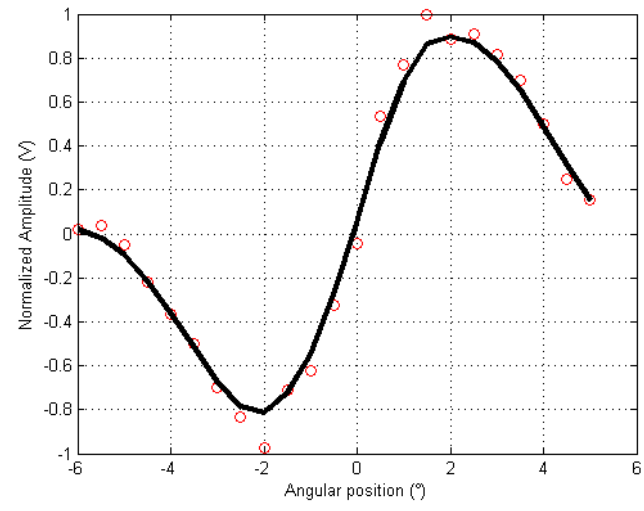
Figure 21. “S” function derived